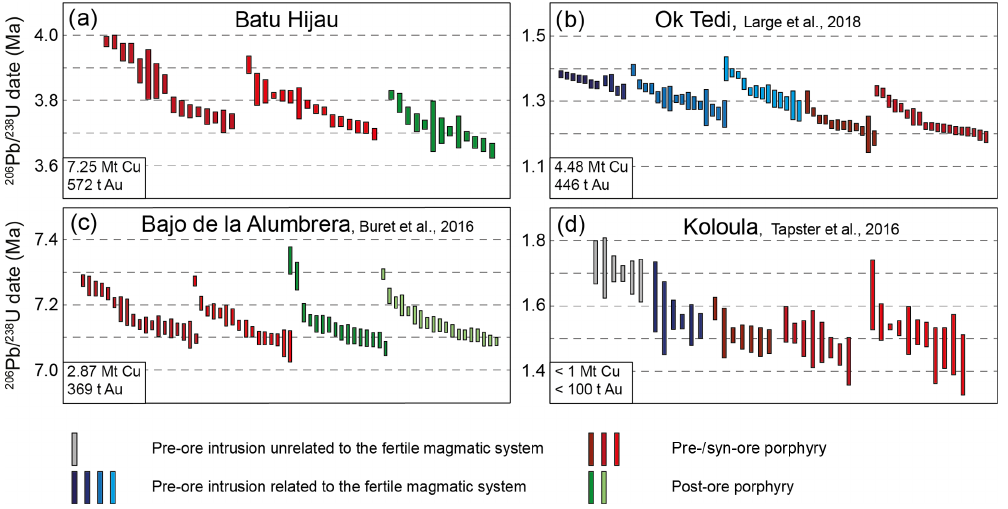
Figure 8. Compilation of high-precision datasets on several pre-, syn- and post-ore intrusions at magmatic–hydrothermal Cu–Au deposits. Data for Ok Tedi, Bajo de la Alumbrera and Koloula are from Large et al. (2018) Buret et al. (2016) and Tapster et al. (2016), respectively. Coloured vertical bars are individual analyses including analytical uncertainty (2 σ ). Intrusions are categorised as pre-ore, pre-/syn-ore and post-ore intrusion. Decreasing deposit size from left to right (tonnages from Cooke et al., 2005).